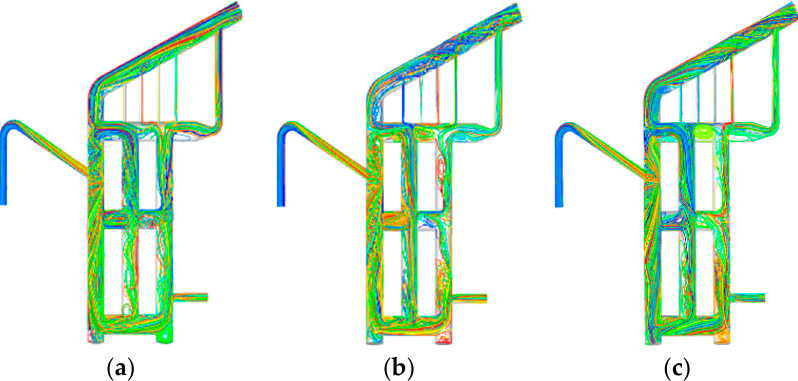
Figure 6. Effect of the flow rate on the gas–liquid separation flow field characteristics. ( a ) 15 m/s; ( b ) 20 m/s; ( c ) 25 m/s. Table 4. Effect of the flow rate on the gas–liquid separation performance.